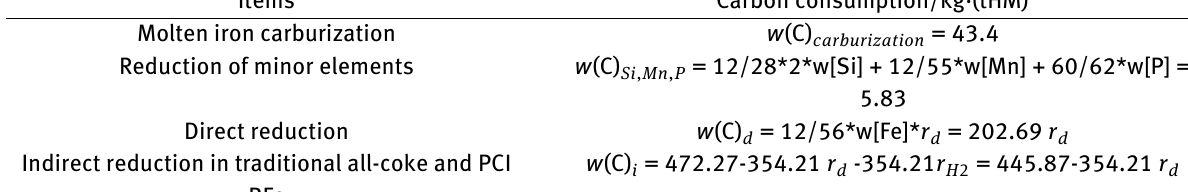
Table 4: Carbon consumption for each processing segment